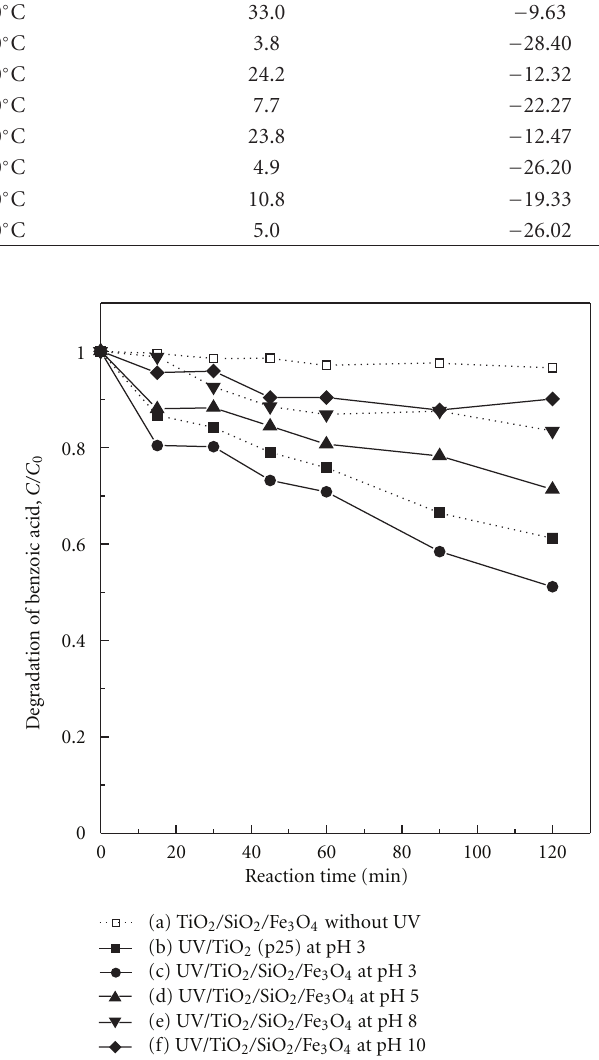
Figure 6: Degradation of benzoic acid by UV/magnetic photocata- lyst process at solution temperature = 20 ◦ C, the initial concentration of benzoic acid = 10 mg L − 1 , TiO 2 /SiO 2 /Fe 3 O 4 = 0.5 g L − 1